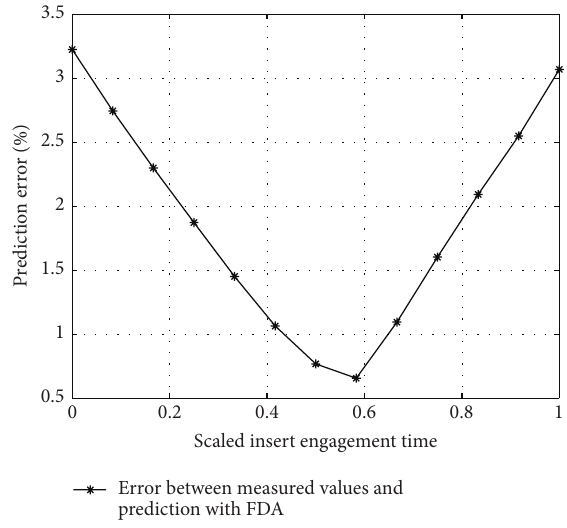
Figure 8: Prediction errors of the model for above-mentioned randomly chosen datum.